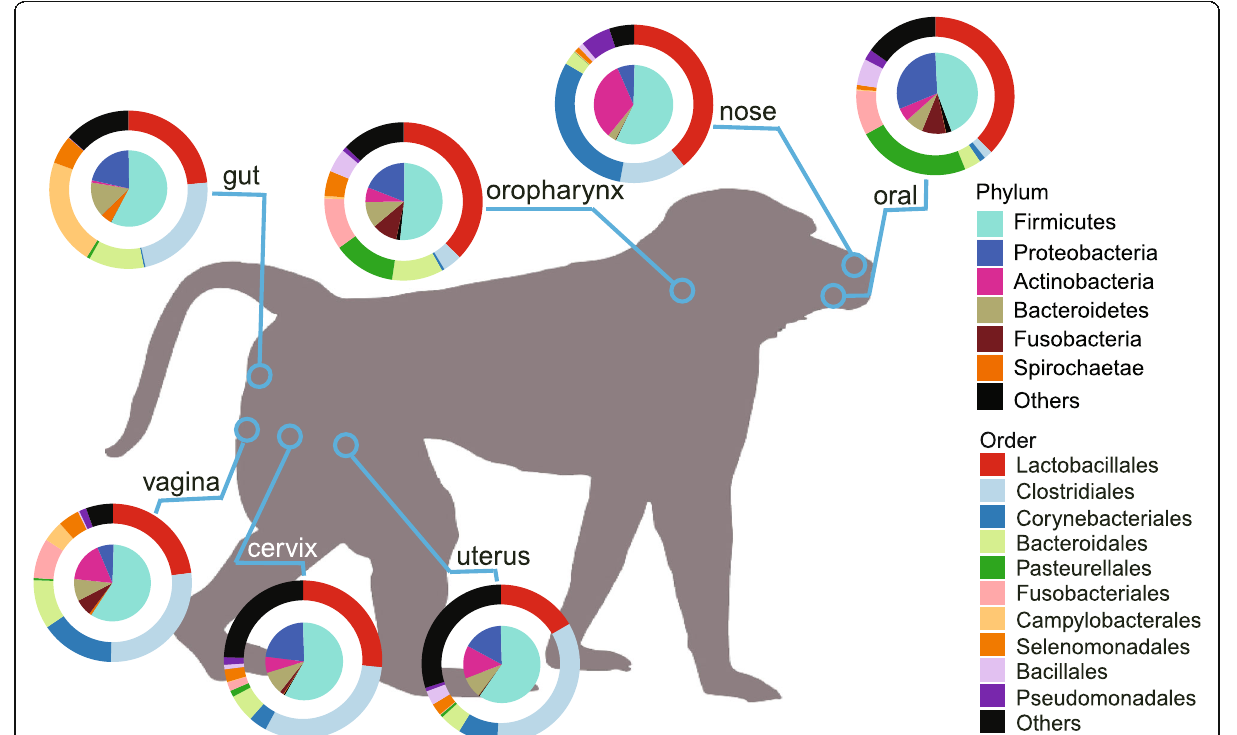
Fig. 1 Microbial composition on phylum and order levels of each anatomic site. Pie charts show the average microbial composition of seven body habitats on order (donut chart) and phylum level (pie chart), respectively. Lactobacillales were found in all the body sites (Mean 27% ± SD